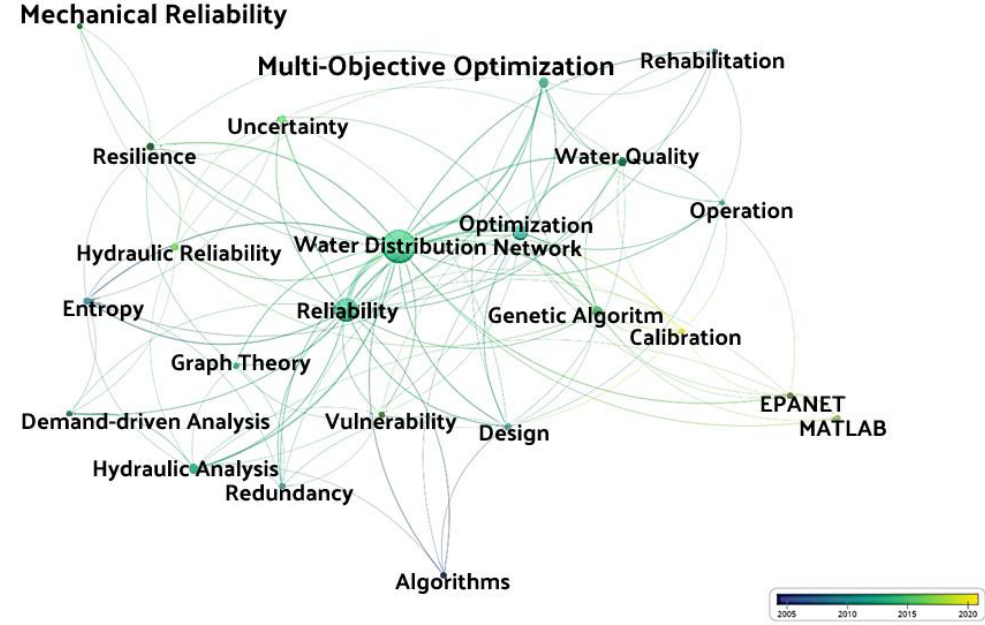
Figure 9. Author keyword evolution over time. Node size represents the number of occurrences of the keyword and the link between two nodes represent their simultaneous occurrences in articles.